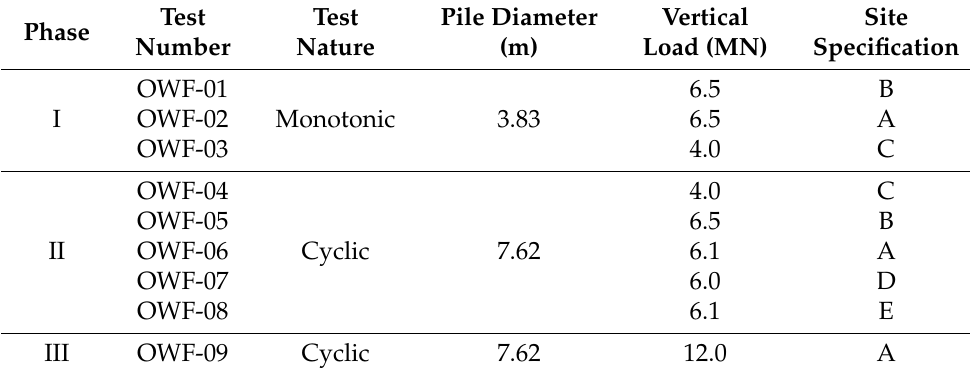
Table 6. Experimental programme on the prototype scale (after